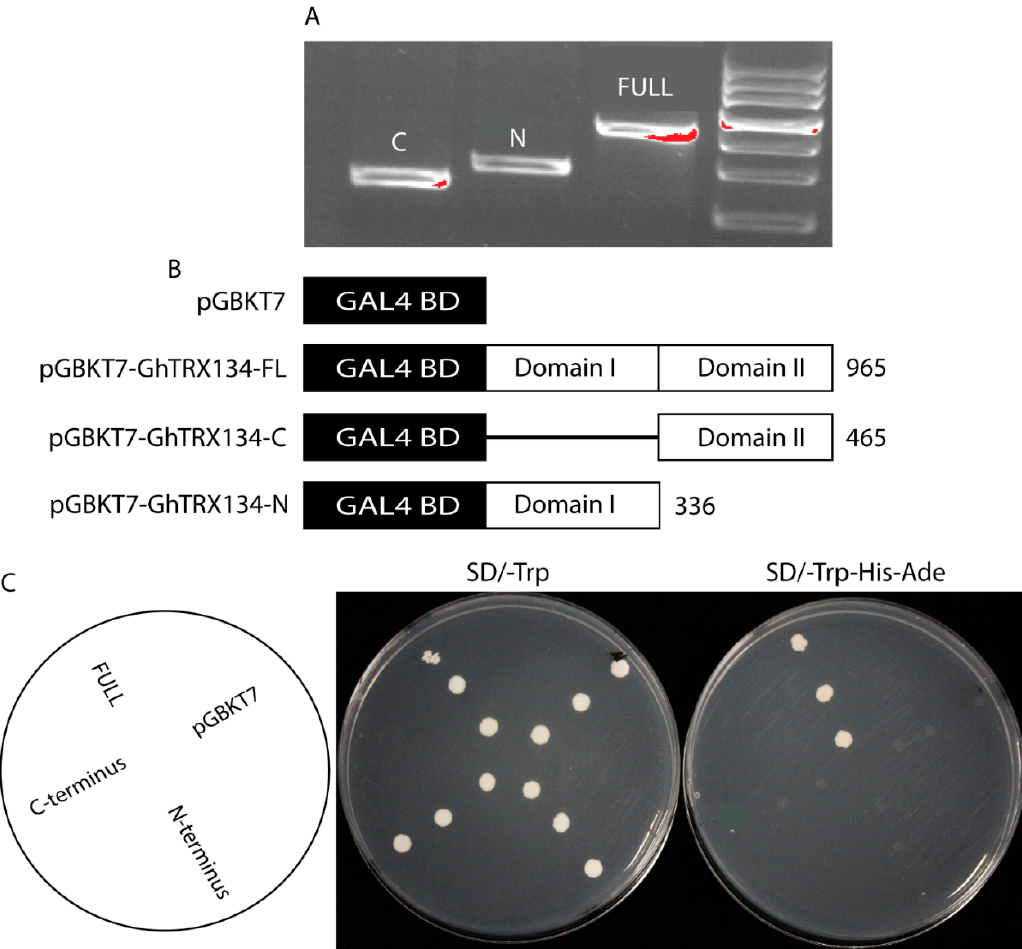
Figure 6. GhTRX134 shows transcriptional activity. ( A ) The size of the GhTRX134 fragments. ( B ) The yeastAH109 strain containing the pGBKT7 empty vector, pGBKT7- GhTRX134 FL (full-length GhTRX134 ), pGBKT7- GhTRX134 -N (N-terminal region of GhTRX134 ), and pGBKT7- GhTRX134 -C (C-terminal region of GhTRX134 ). ( C ) Transformants were streaked on synthetic dextrose medium lacking tryptophan (SD-Trp) medium (control) and synthetic dextrose medium lacking tryptophan, histidine, and adenine (SD-Trp-His-Ade) medium (selective) to examine HIS3 and ADE2reporter gene activation. The media with yeast cells were incubated for 3 days at